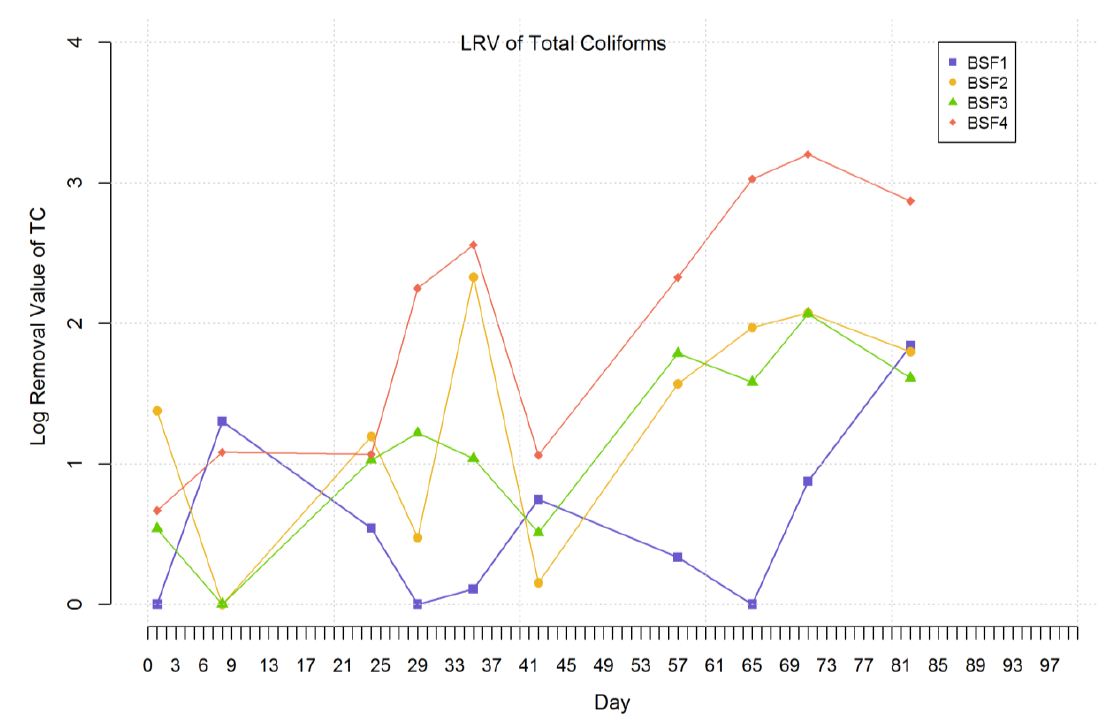
Figure 7. Log removal values of total coliforms throughout the experiment.